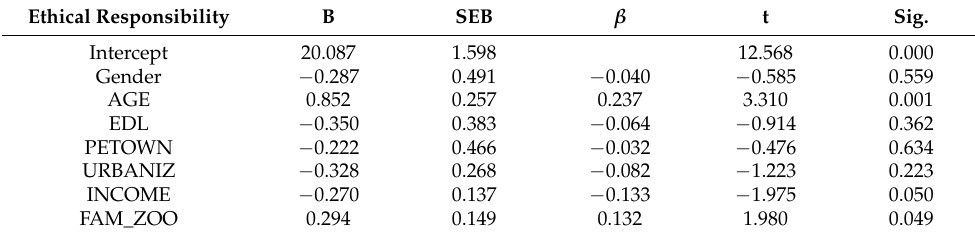
Table 9. Results of the multiple regressions applied to predict differences in ethical responsibility (ETR) from gender, age, and education level (EDL), pet ownership (PETOWN), urbanization (UR- BANIZ), income level (INCOME), and zoo familiarity (FAM-ZOO). In the table the p -values < 0.05 indicate the corresponding variable is a statistically significant predictor of the outcome